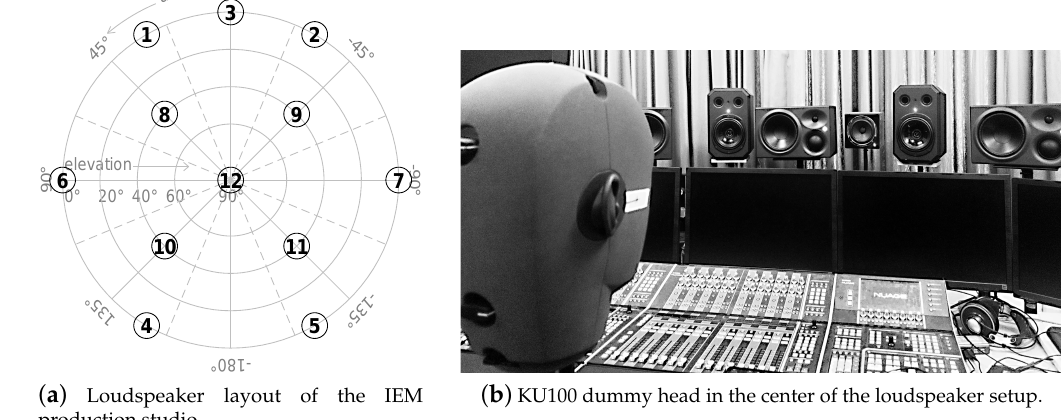
Figure 1. Binaural room impulse response measurement